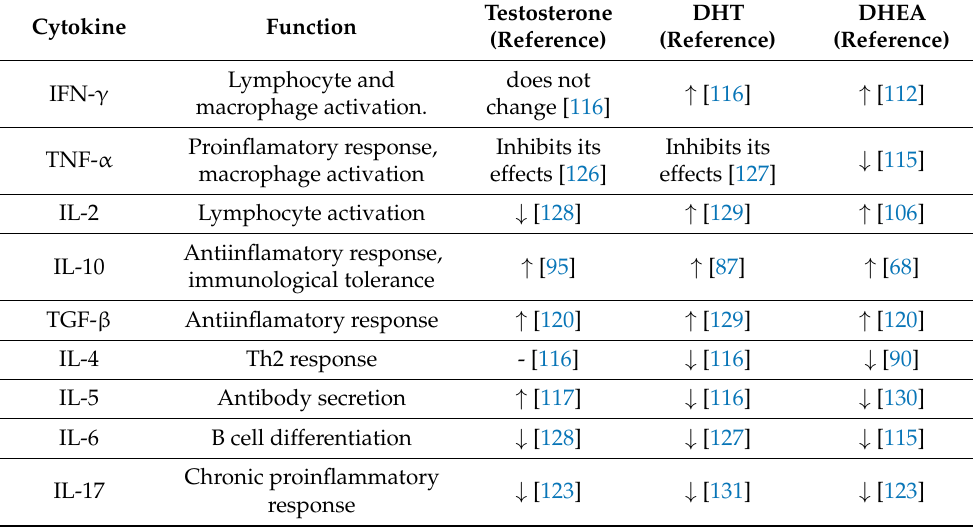
Table 2. Effect of androgens on